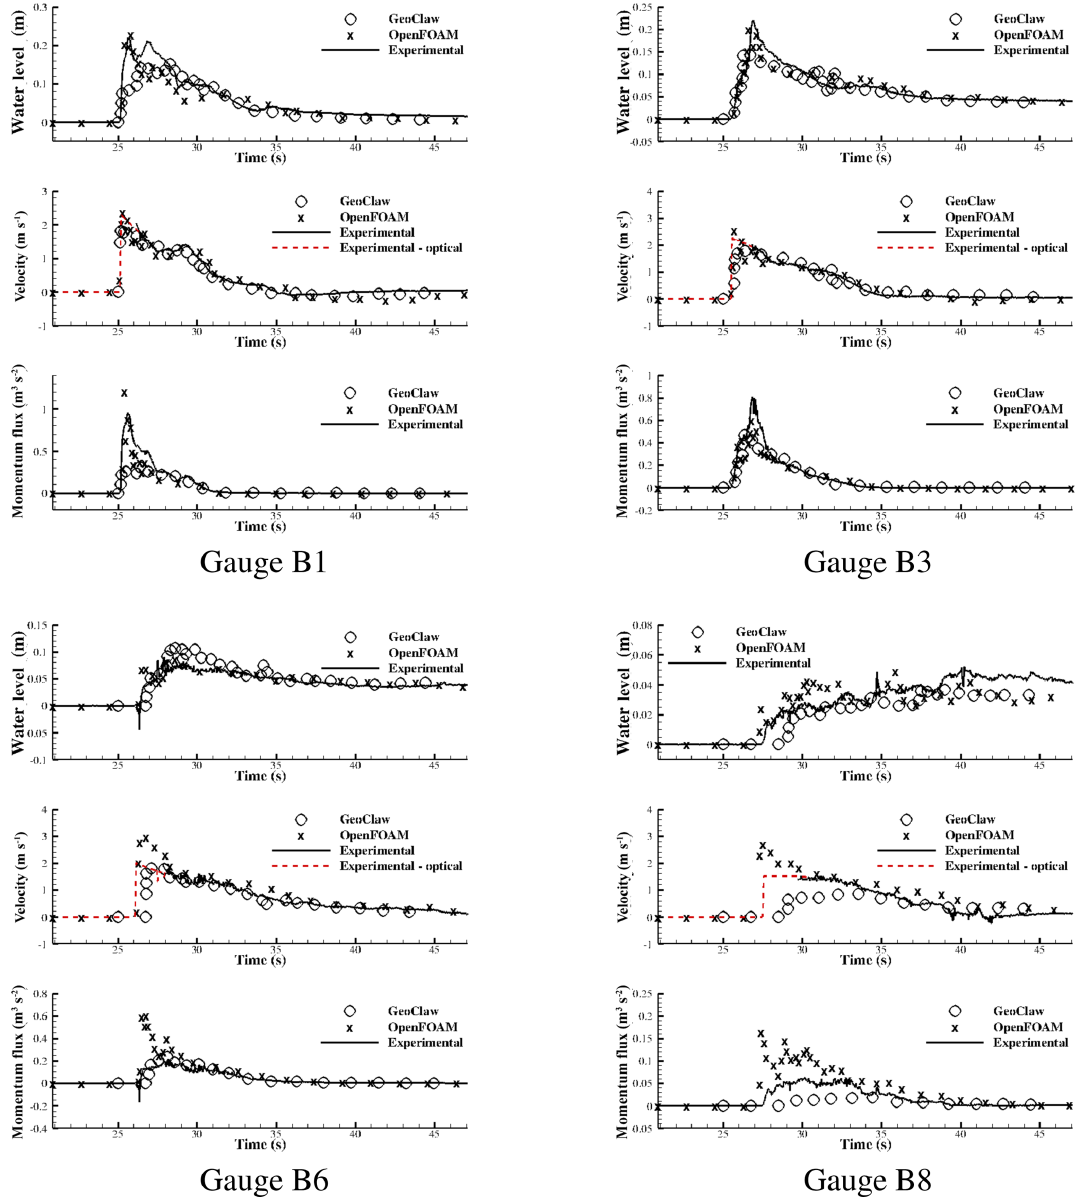
Figure 9. Time histories of surface elevation, cross-shore velocity, and momentum flux at some selected gauges along line